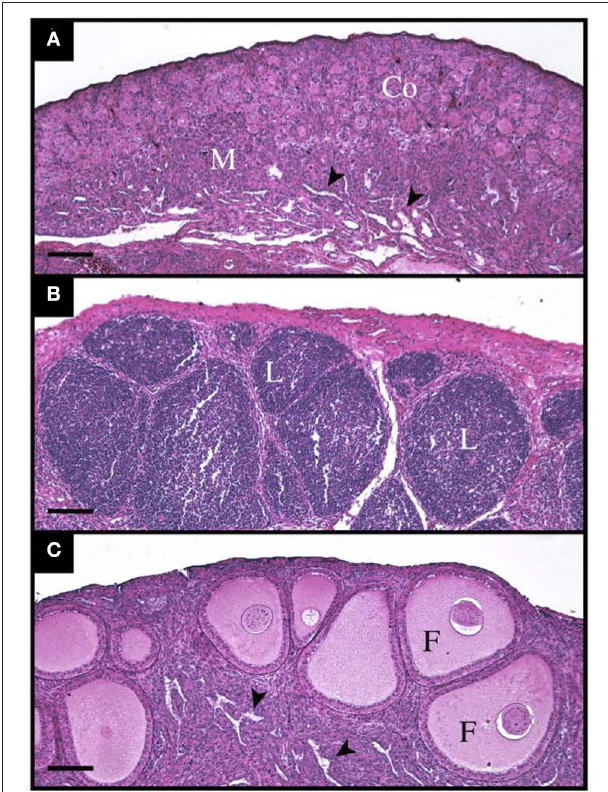
FIGURE 4 | Histological appearance of tissue before, and 35 days post transplantation with and without immunosuppressants. (A) Shows 8-day old ovarian tissue before transplantation with a clear cortex (Co) and medulla (M) with lacunar channels (arrowheads) visible. (B) Shows an ovarian transplant 35 days post-surgery from an unsuppressed recipient. The entire graft is infiltrated by lymphocytic masses (L). (C) Also shows a transplant 35-days post-surgery, however this poult was treated with Cyclosporin A at 25 mg/kg/day. Normal follicles (F) can be seen throughout the cortex and lacunar channels (arrowheads) within the medulla.